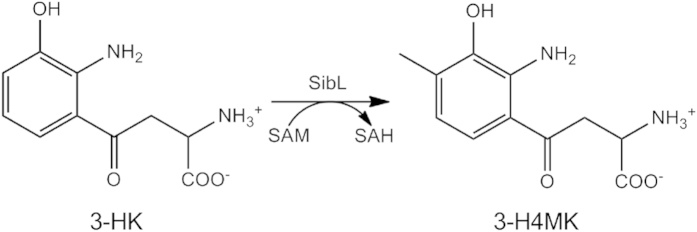
A schematic representation of the Ss-SibL enzymatic reaction.